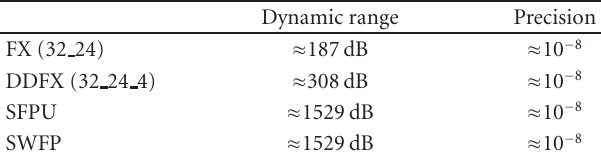
Table 1: Precision and dynamic range results. Also see [35].